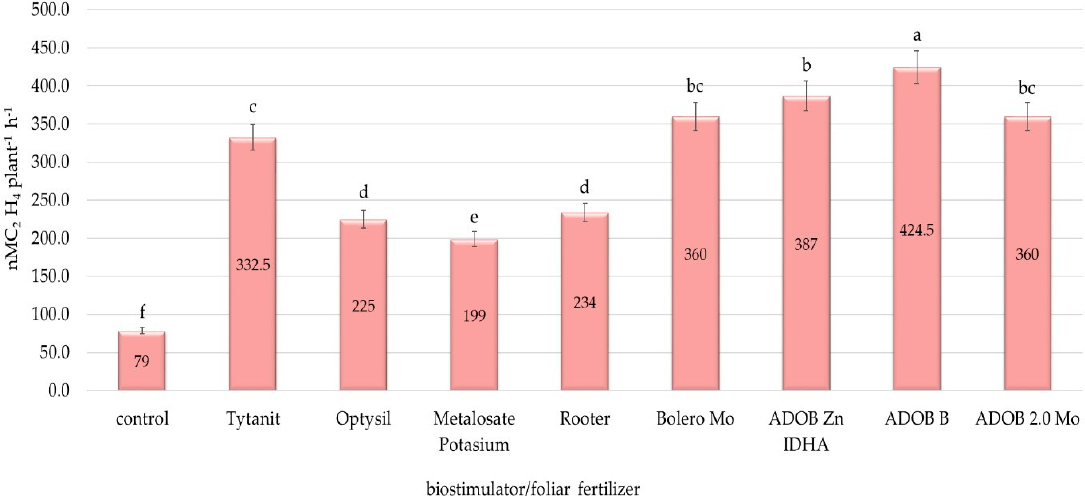
Figure 2. The influence of the bio-stimulants and fertilizers on the level of biological fixation of nitrogen. Abbreviation: means values ± standard errors; a, b, c, d, e, f—homogenous groups according to Duncan’s test at level p = 0.05.